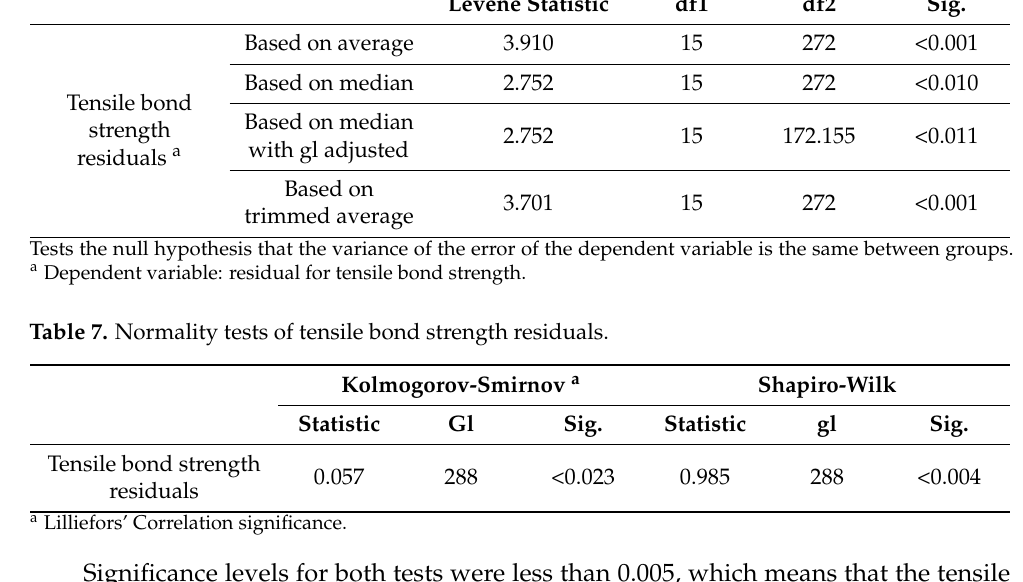
Table 6. Levene’s error variance equality test. Levene Statistic df1 df2 Sig.